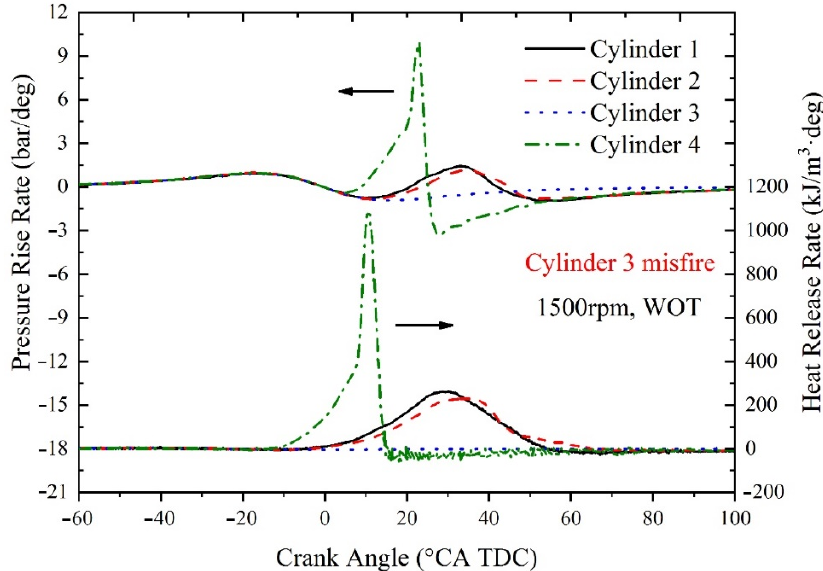
Figure 7. The pressure rise rate and heat release rate of the four cylinders in Figure 6b.